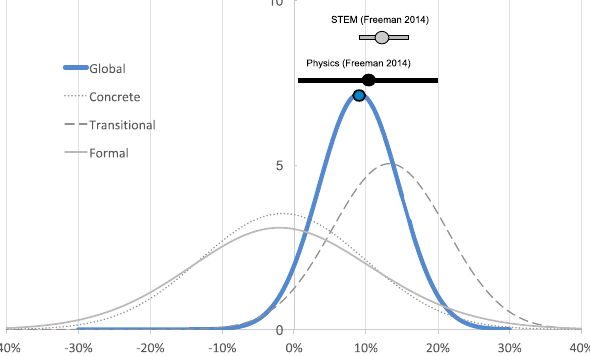
FIG. 3. Difference in failure rate between experimental and control groups. Probability distributions for the whole student universe as well as distinction of concrete, transitional, and formal reasoning skills are